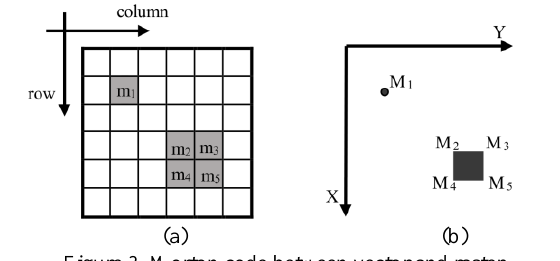
Figure 3. Morton code between vector and